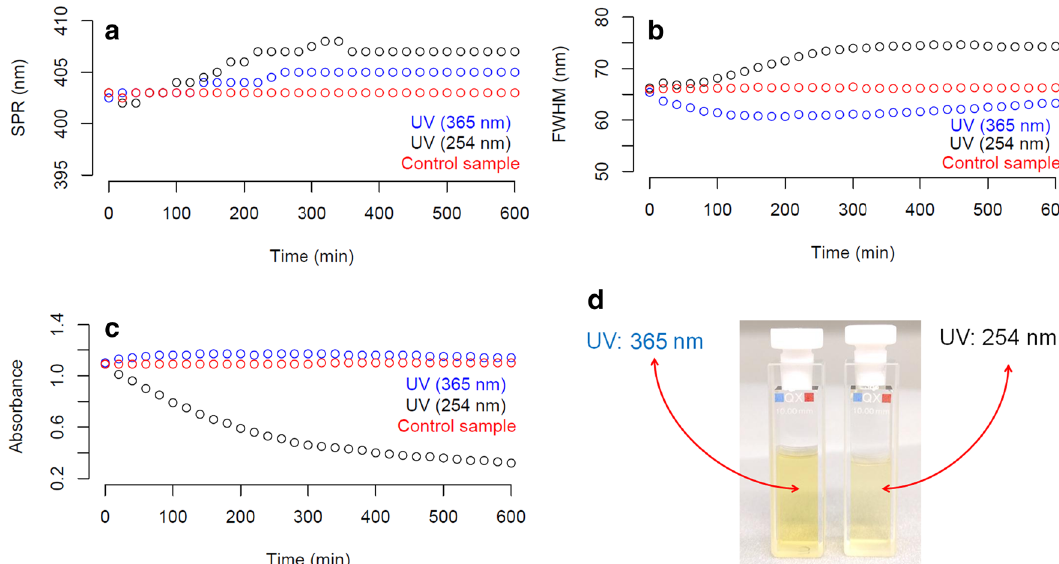
Figure 7. Short-term stability of sub-15 nm AgNPs exposed to UVC (254 nm) and UVA (365 nm) radiation. ◦ ( a ) λ SPR , ( b ) FWHM, ( c ) Abs MAX , ( d ) AgNP suspensions after UVC and UVA exposition. Black dots ( ) represent ◦ measurements of AgNPs exposed to UVC radiation, blue dots ( ) represent measurements of AgNPs exposed to ◦ UVA radiation, red dots ( ) represent measurement of the control